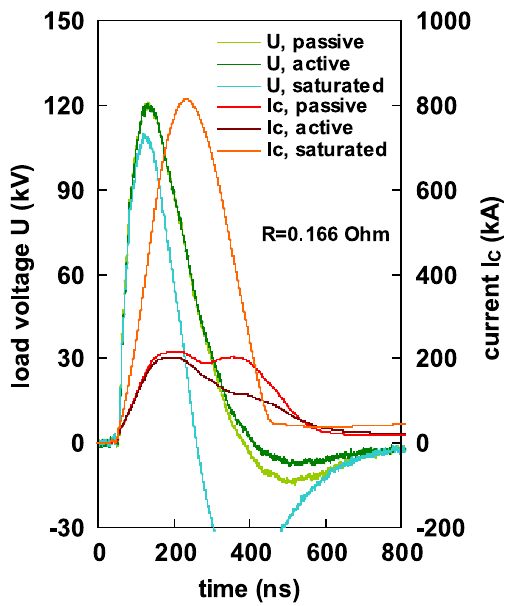
FIG. 9. (Color) Load voltage U and current around the core I C at R ¼ 0 : 166 Ohm depending on the premagnetizing method.